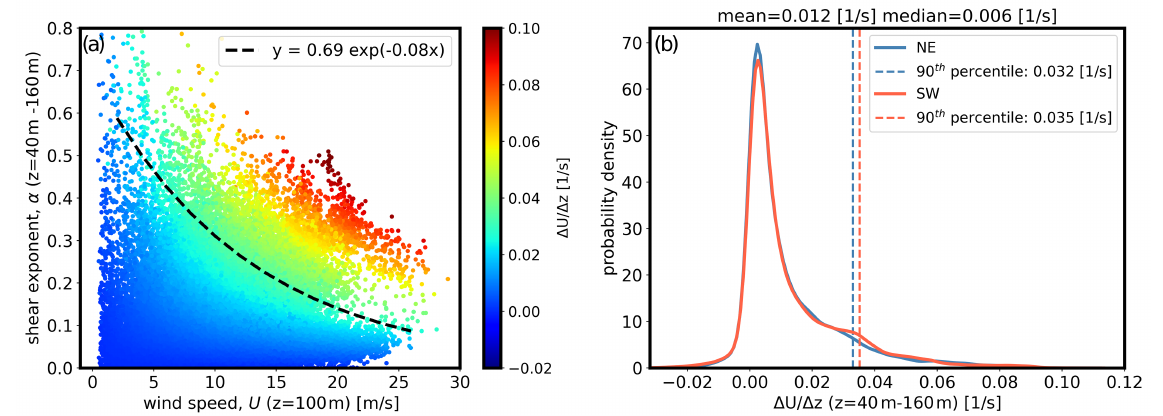
Figure 4. An analysis of vertical wind shear parameters from the NE floating lidar. Panel (a) shows the relationship between the wind speed at 100m height ( U 100m ), the power-law exponent between height 40 and 160m ( α ), and the wind speed gradient between 40 and 160m ( (cid:49)U/(cid:49)z ). The dashed black line represents the 90th percentile value of (cid:49)U/(cid:49)z . Panel (b) shows the probability distribution of (cid:49)U/(cid:49)z for both